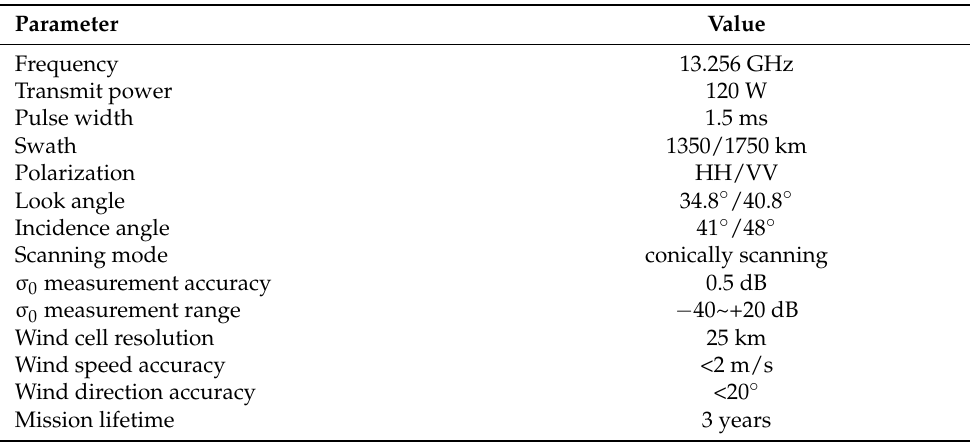
Table 2. Main parameters of the HY-2 scatterometer.